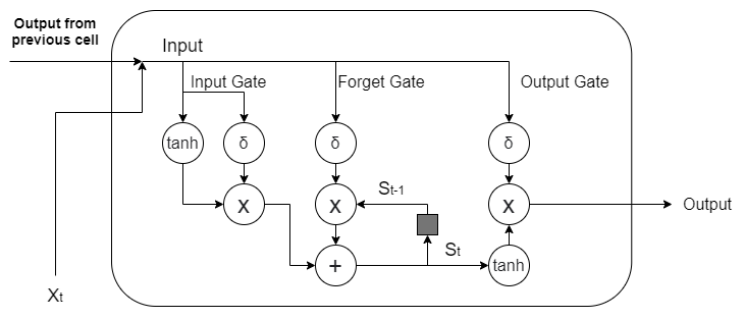
Figure 3. LSTM cell structure, adapted from